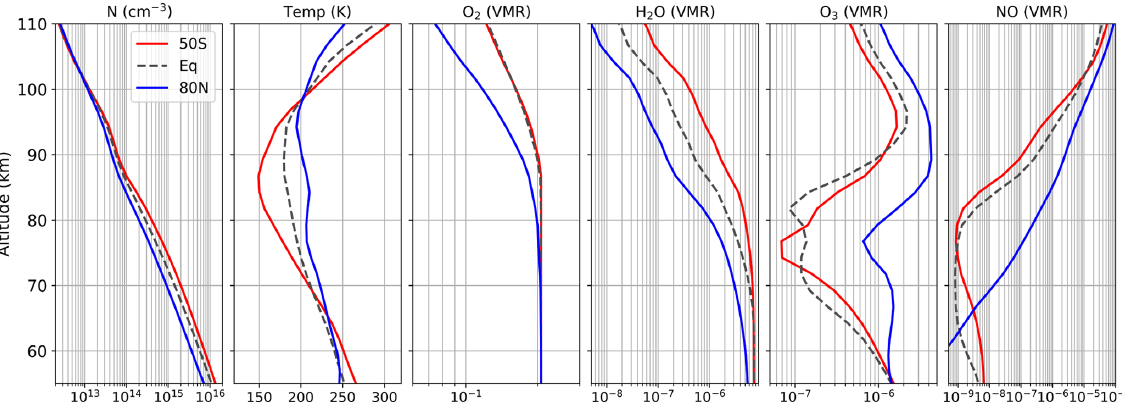
Figure 7. Vertical profiles of atmospheric number density, temperature and VMRs of O 2 , H 2 O, O 3 and NO. They are representative of a Northern Hemisphere winter period (DJF), during daytime at 50 ◦ S and the Equator (dashed-grey and red lines, respectively), and polar night at 80 ◦ N (blue